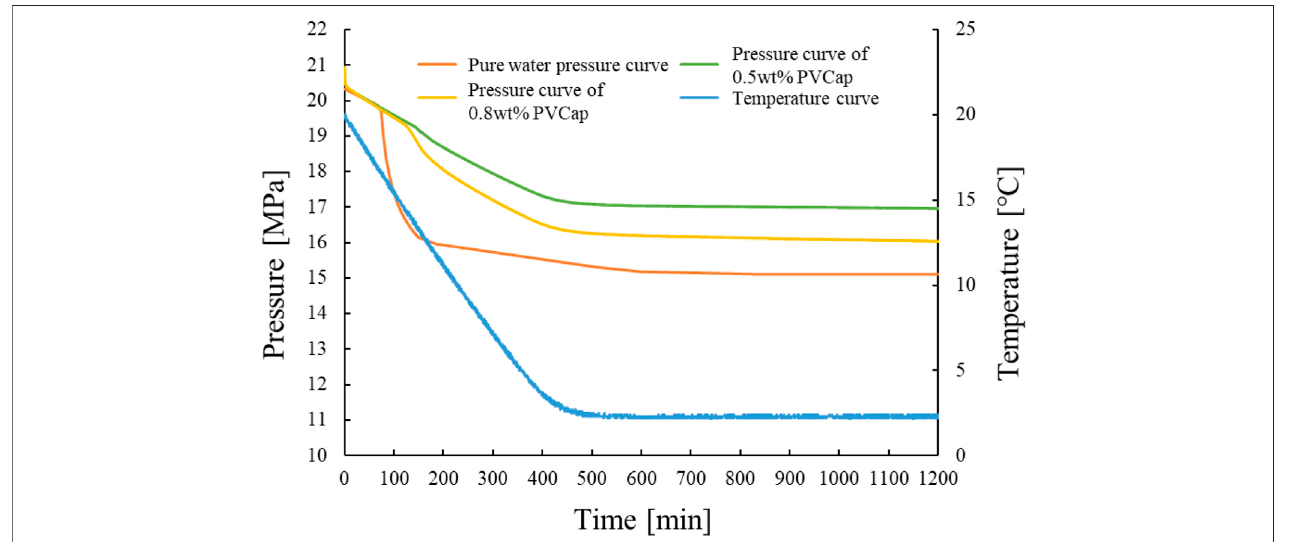
FIGURE 4 | Temperature and pressure pro fi les for hydrate formation with different concentrations of